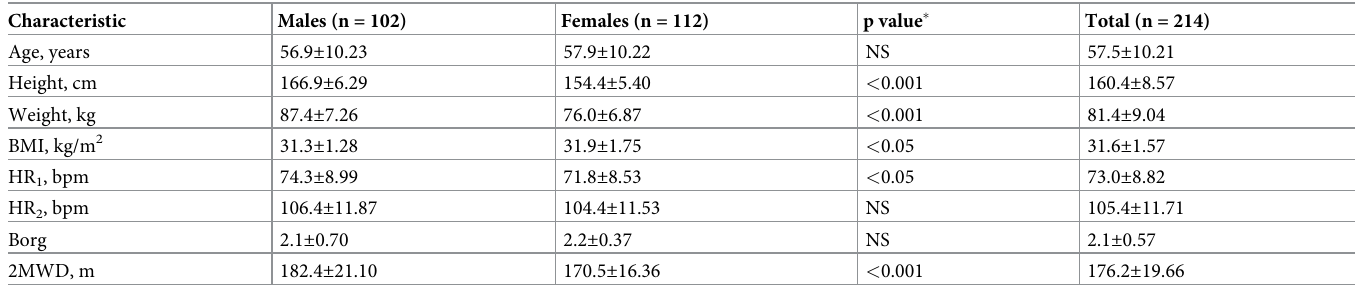
Table 1. Characteristics and 2MWT results of the study participants.